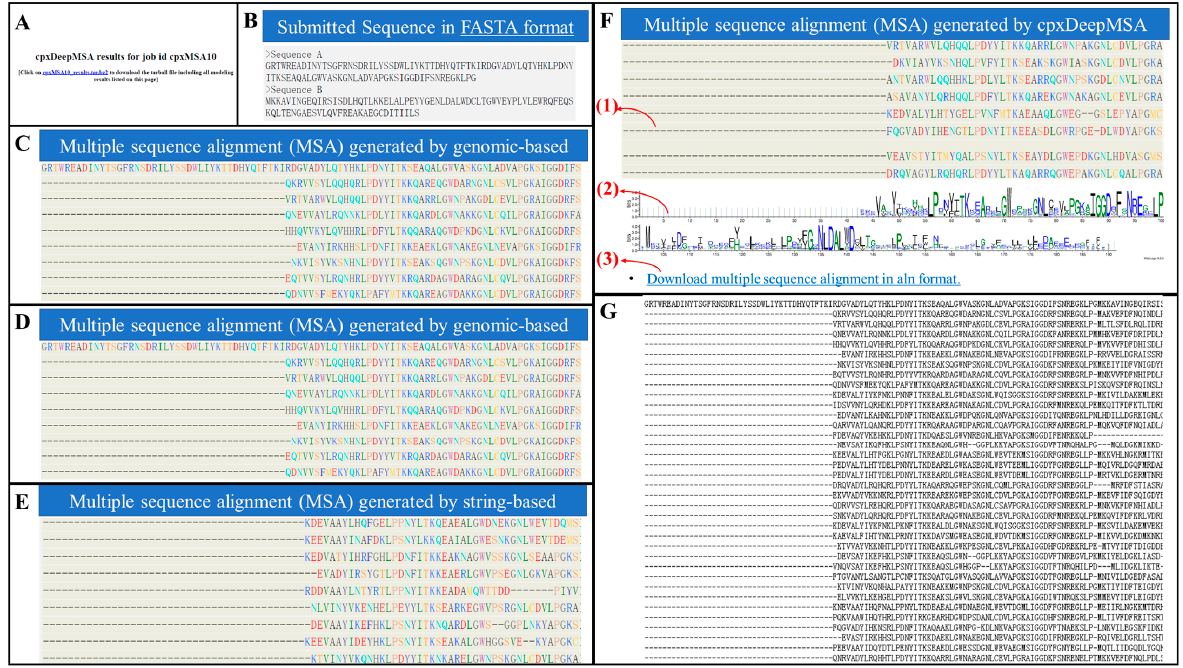
Figure 3. Illustration of the cpxDeepMSA server output, including ( A ) a summary of the multiple sequence alignment results; ( B ) summary of the user input; ( C – F ) protein complex multiple se- quence alignment-generated-based string, genomics, phylogeny, and cpxDeepMSA, respectively; ( G ) multiple sequence alignment file.